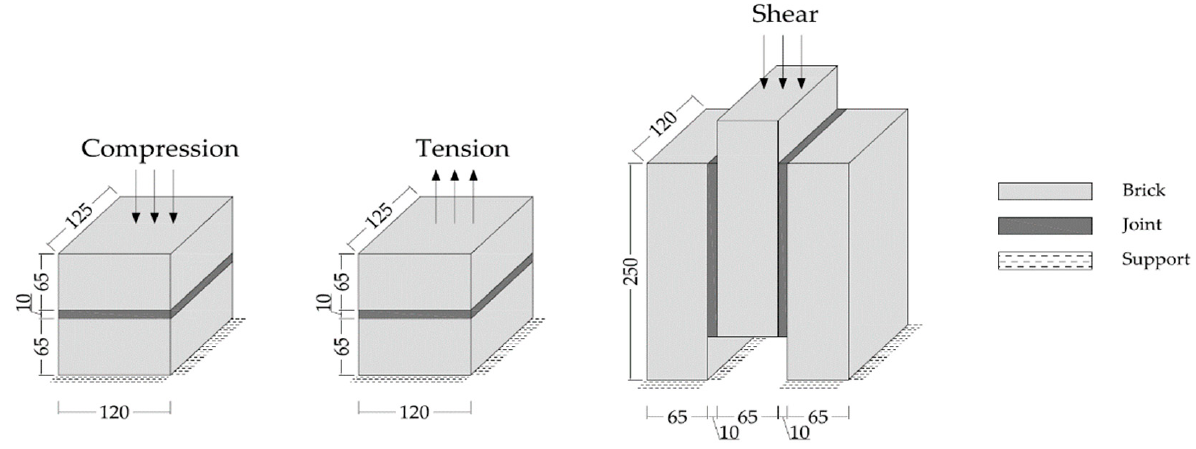
Figure 9. Adapted test configuration of the small size specimens [mm] from Reference [52].